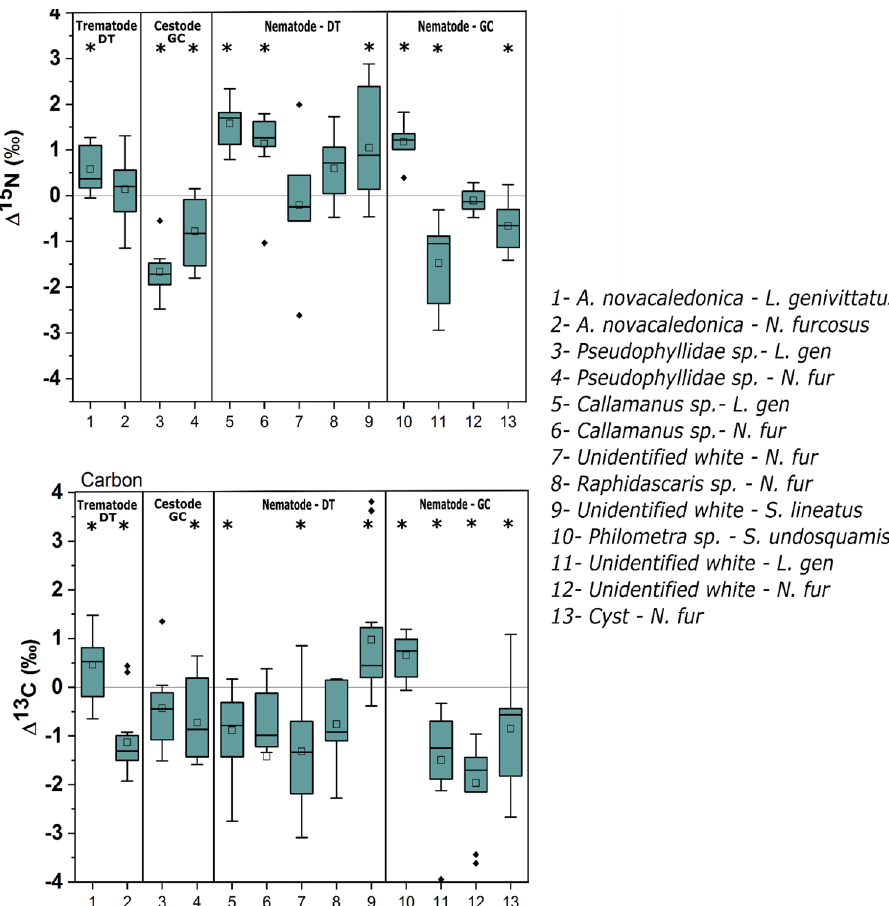
Figure 2. Δ 15 N and Δ 13 C values (‰) for parasite–host couplings examined in this study. Asterisks indicate significant differences between host and parasite at an α = 0.05. Dietary tract (DT) and general cavity (GC) refer to the parasite habitat within fish hosts. For the boxplots, squares indicate mean, lines indicate median, boxes indicate upper and lower quartiles, and whiskers indicate 1.5 quartile ranges. Black diamonds are